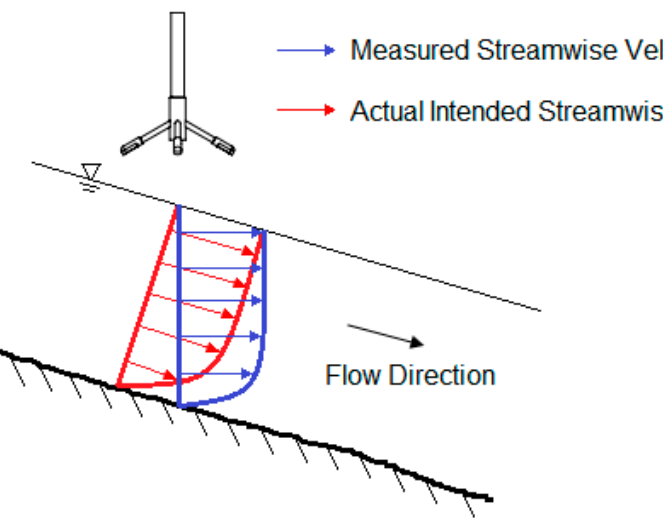
Figure 1. Discrepancy between the measured and actual intended flow velocity profiles.